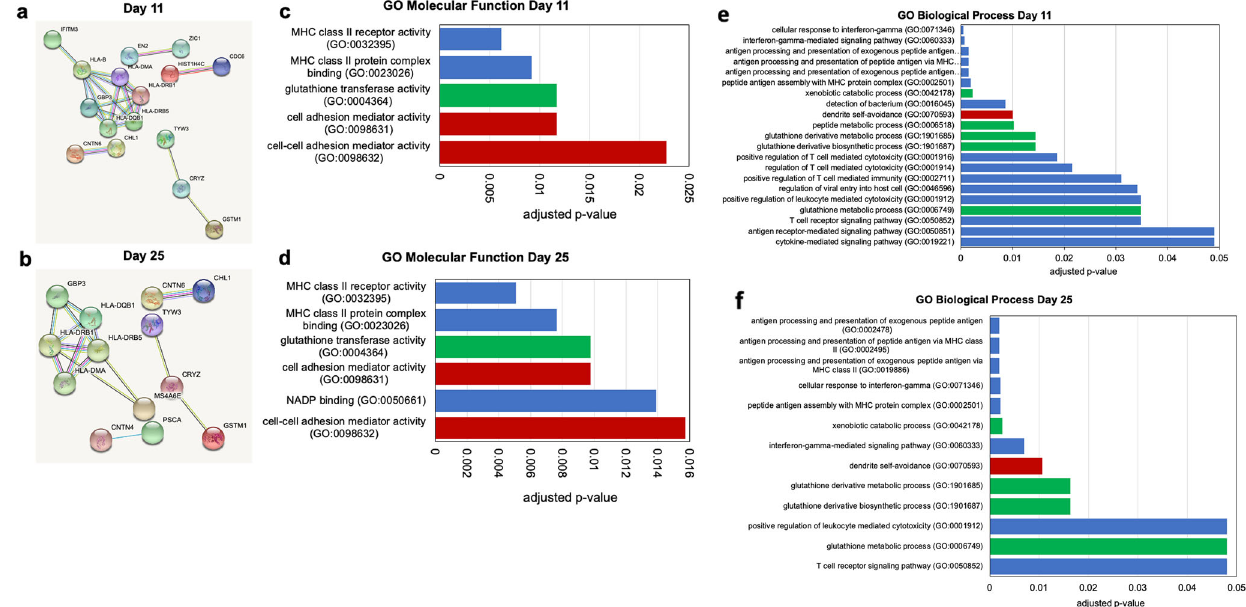
Fig. 8 Pathway analysis of signi fi cantly differentially expressed genes. a , b STRING networks with differentially expressed genes on day 11 ( a ) and day 25 ( b ). Only those genes connected to a node are shown. c , d Statistically signi fi cantly different GO Molecular Functions and e , f GO Biological Processes (FDR < 0.05) determined from the differentially expressed genes for day 11 ( c , e ) and day 25 ( d , f ) of differentiation are plotted. Pathways relating to GSH metabolism are indicated in green, neural development in red and all others in blue. The GO Biological Processes labelled in blue involve MHC class II gene expression, genes which have been demonstrated to play a role in neural development independent of their function in cell